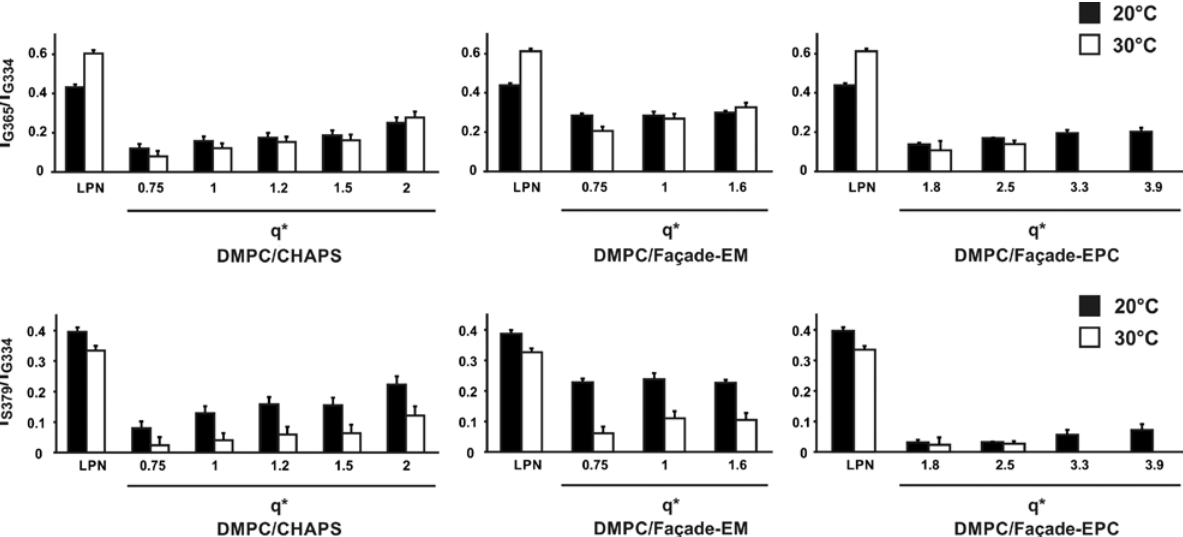
Figure 5: Quality of NMR spectra of the p75NTR DD in various bicelles. The ratios of the intensities of signals, corresponding to G365 and S379 from the DD of p75- Δ ECD, over the intensity of signal, corresponding to G334 from the flexible linker, connecting the DD and TM domain of the protein, are shown for MSPD1/DMPC LPNs [10], DMPC/CHAPS, DMPC/Façade-EM, and DMPC/Façade-EPC bicelles formed at various q * . Data were obtained at 20 ° C (filled bars) and 30 ° C (empty